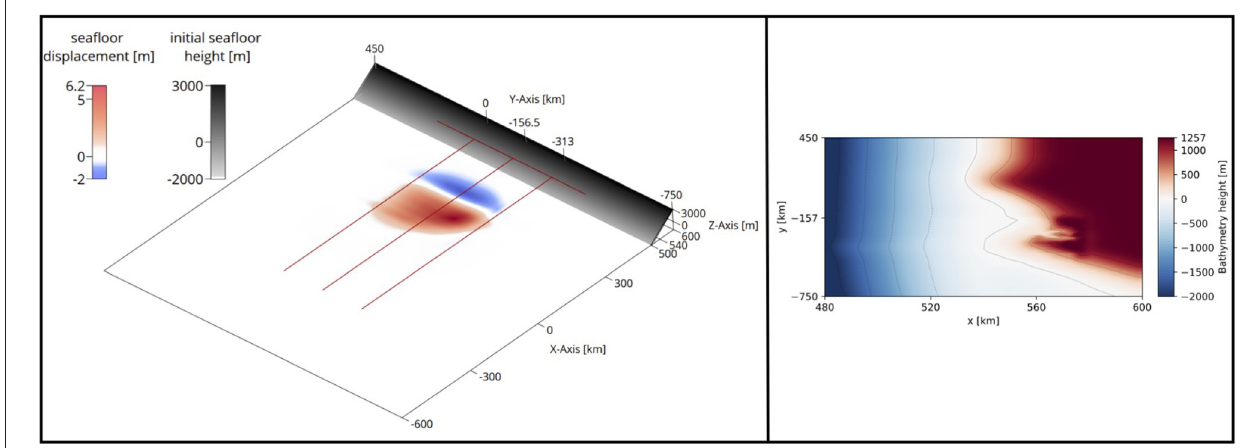
FIGURE 3 | (Left) Sketch of the tsunami model setup for most scenarios for sam(oa) 2 -flash with a linearly sloping beach starting at x = 500 km. Red and blue colors are an exemplary snapshot of seafloor uplift and subsidence resulting from a DR model that are used to source the tsunami model. (Right) Zoom-in of the non-linear height profile of the complex beach used in one tsunami scenario (model 4.D) adapted from the Okushiri benchmark. The position and slope are designed to be comparable to the linear beach (left) . The depth profile is illustrated by blue and red colors. Contour lines are shown every 500 m. slip rates and rupture velocities, and include localized supershear rupture at different simulation times and fault